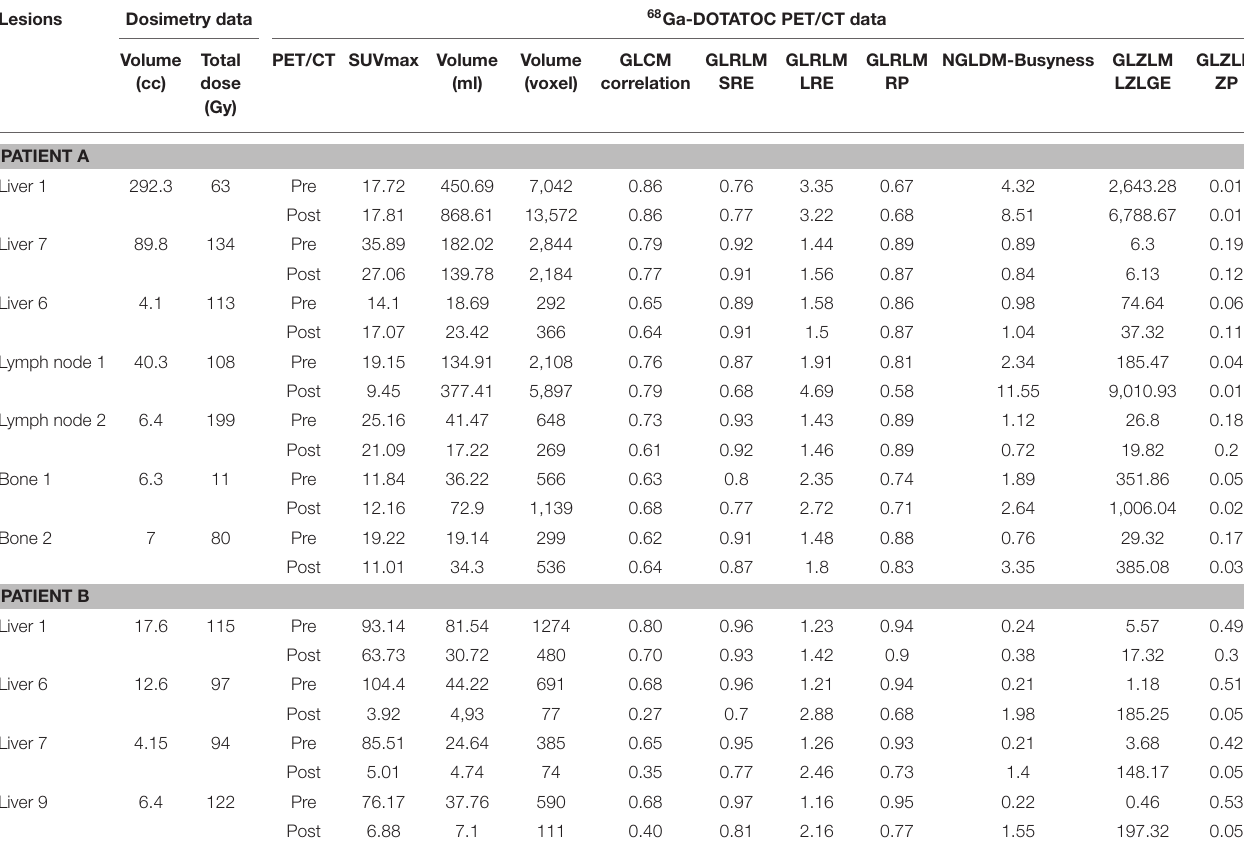
TABLE 1 | Dosimetry data extracted by the first cycle of therapy.